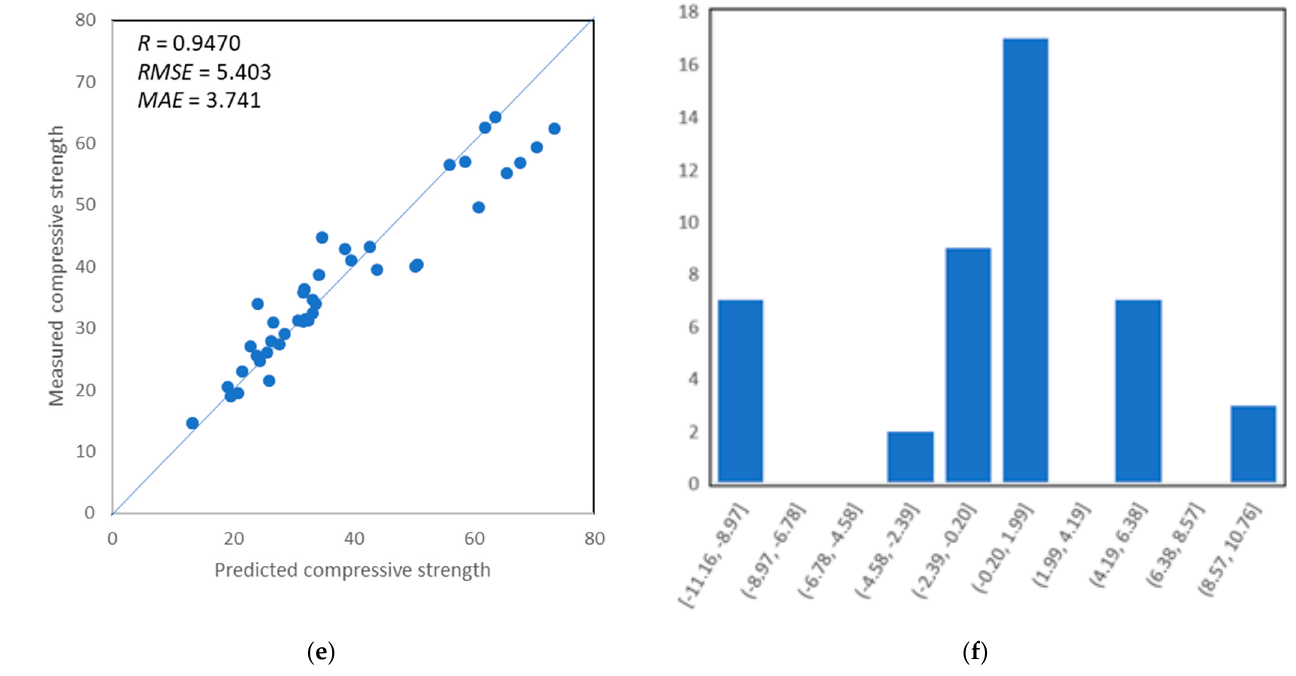
Figure 10. ( a ) Predictions vs. target data of training set; ( b ) error distribution of GEP model with prediction versus training set; ( c ) predictions vs. target data of validation set; ( d ) error distribution of GEP model with prediction versus validation set; ( e ) predictions vs. target data of testing set; ( f ) error distribution of GEP model with prediction versus testing set.